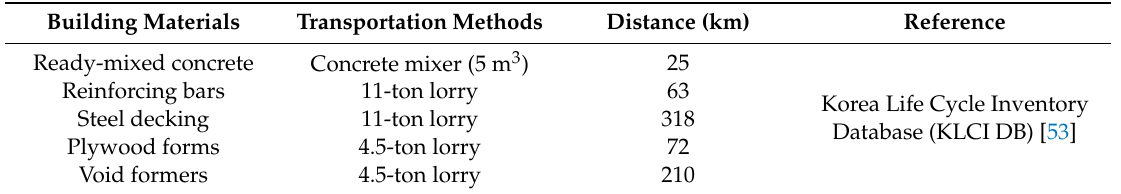
Table 1. Transportation methods of building materials.